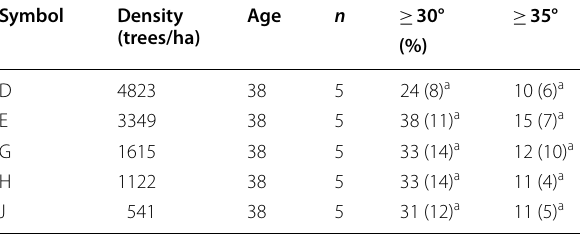
Table 3 Ratio of tracheids with unusually large MFA in the ring number 22 among tree-density-zoning symbols